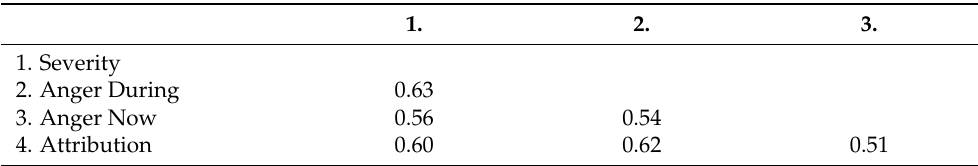
Table 2. Within-person correlations for perceived child